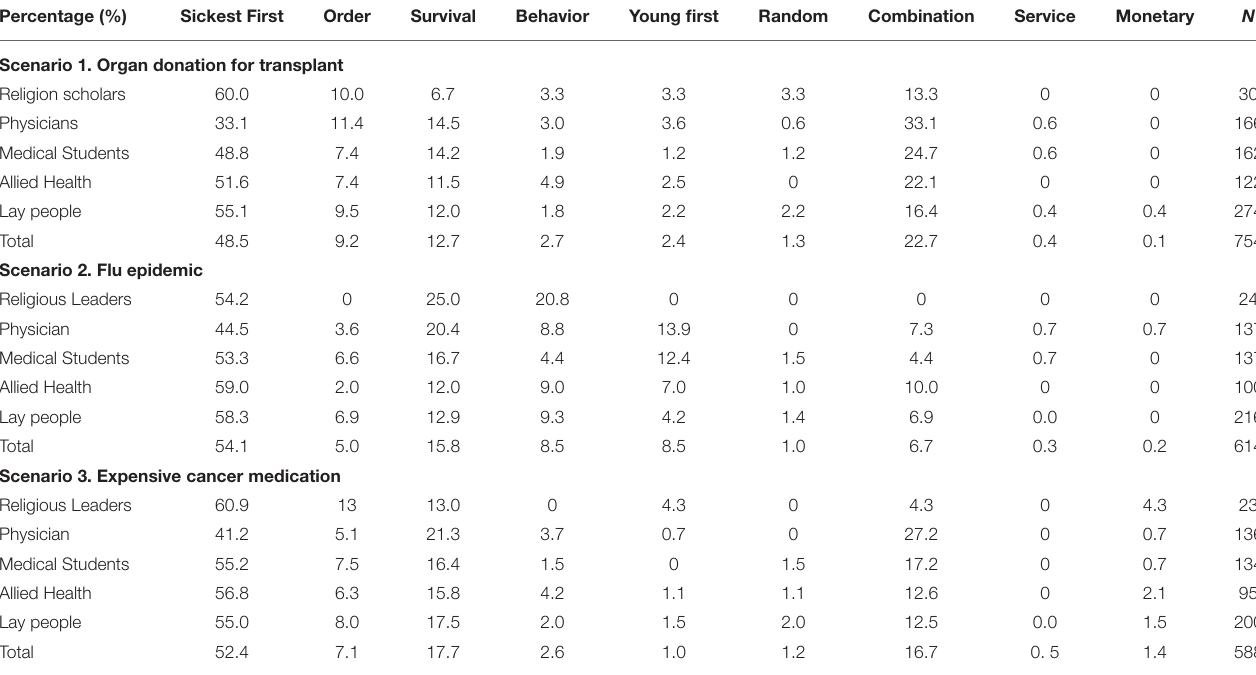
TABLE 2 | Percentages of respondents who chose each allocation principle as the most important one among the study group. Percentage (%) Sickest First Order Survival Behavior Young first Random Combination Service Monetary N Scenario 1. Organ donation for transplant Religion scholars